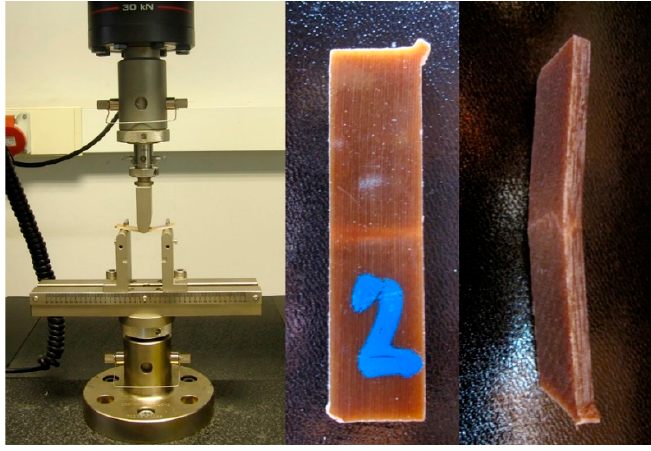
Figure 2. Three-point bending test.